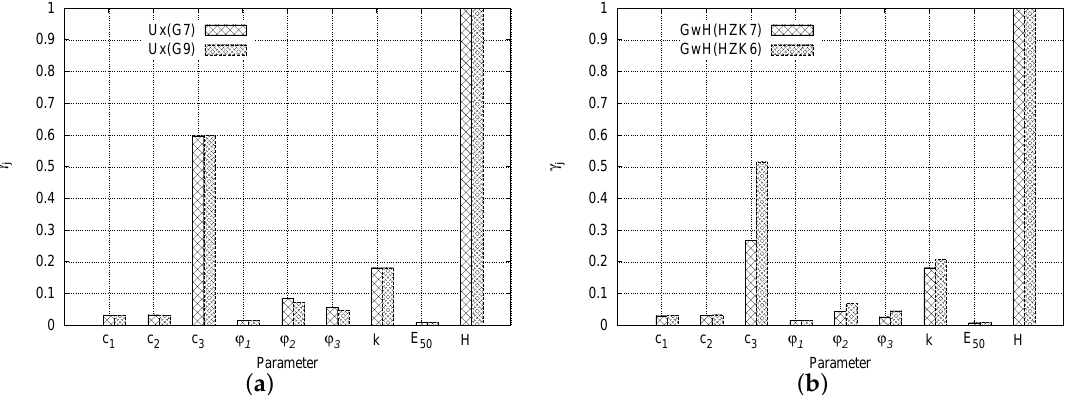
Figure 9. LSA results for: ( a ) horizontal displacements at G7 and G9, ( b ) groundwater level at HZK6 and